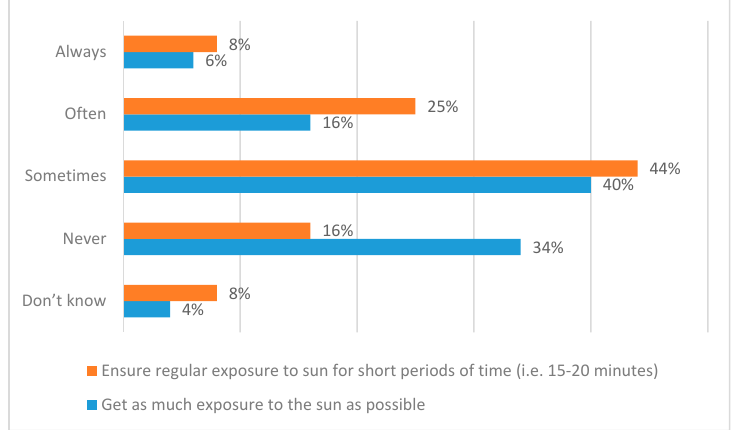
Figure 5. Frequency of specific sunlight exposure behaviours (spring and summer months, April to September).